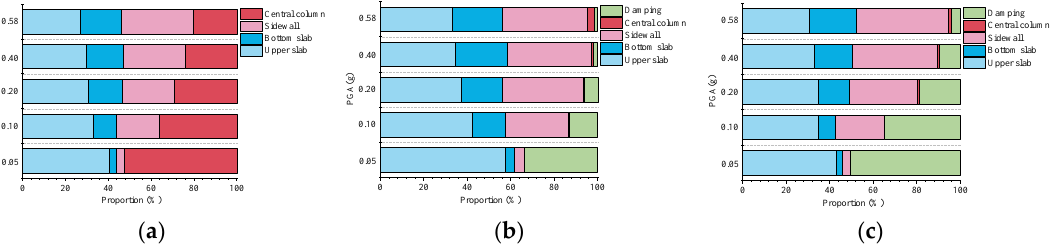
Figure 16. Histogram of energy proportions for ( a ) uncontrolled US, ( b ) US-CIS and ( c ) US-NSAS